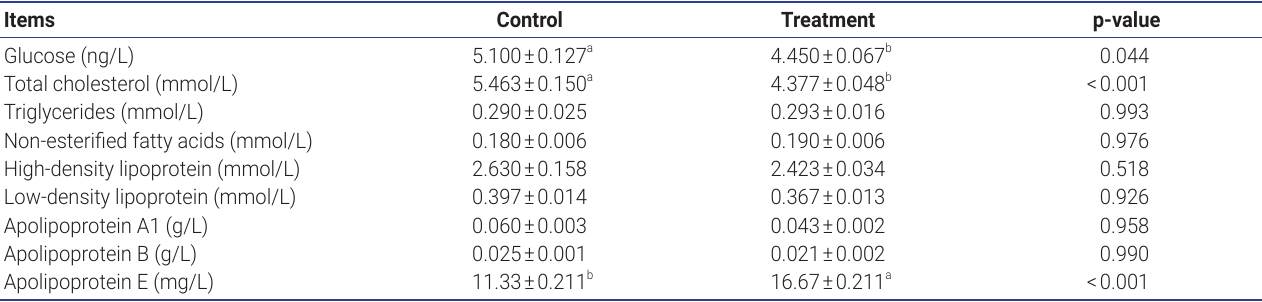
Table 4. Effects of photoperiod on serum lipid metabolism index of Jinjiang cattle Items